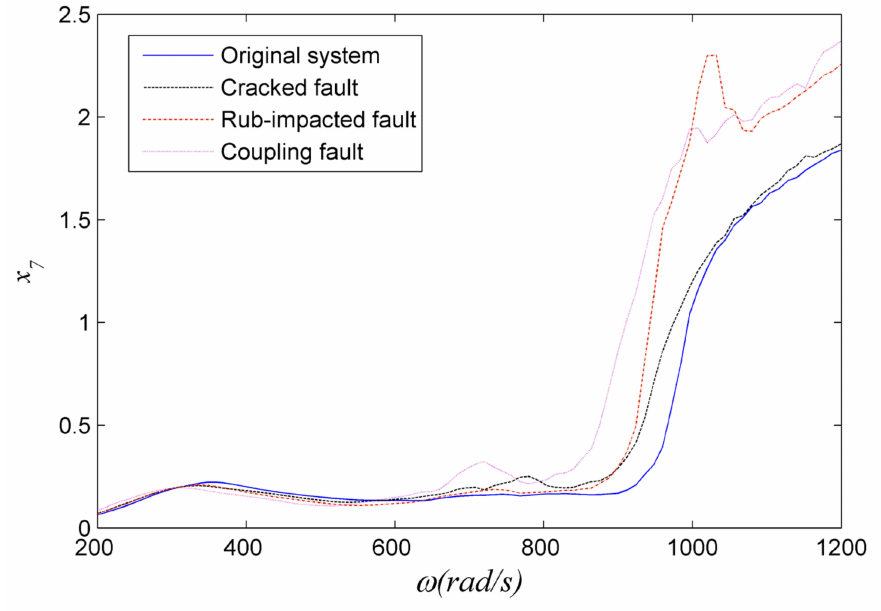
Figure 3. Comparison of amplitude–frequency